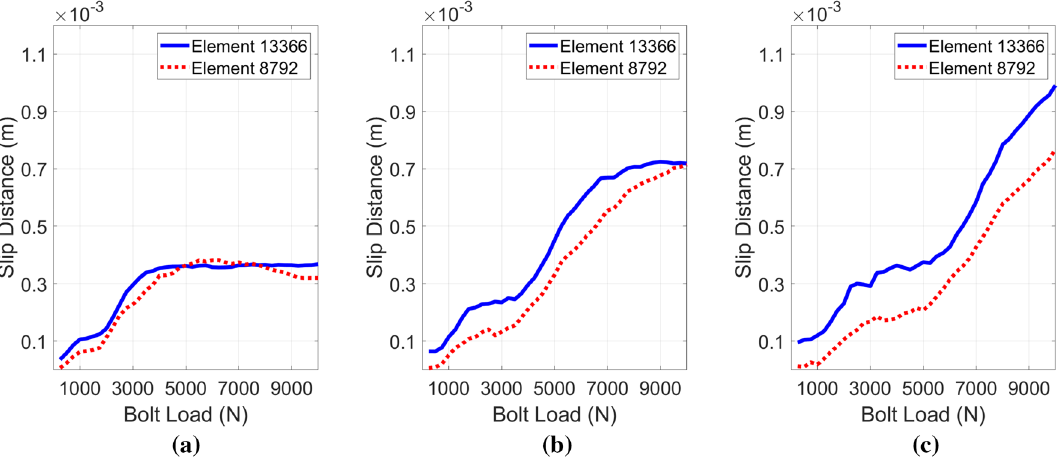
Fig. 12 Slip Distance (m) over 0.05 s at element 13,366 with a 500 N, b 1000 N and c 1500 N excitation amplitude, the first mode of